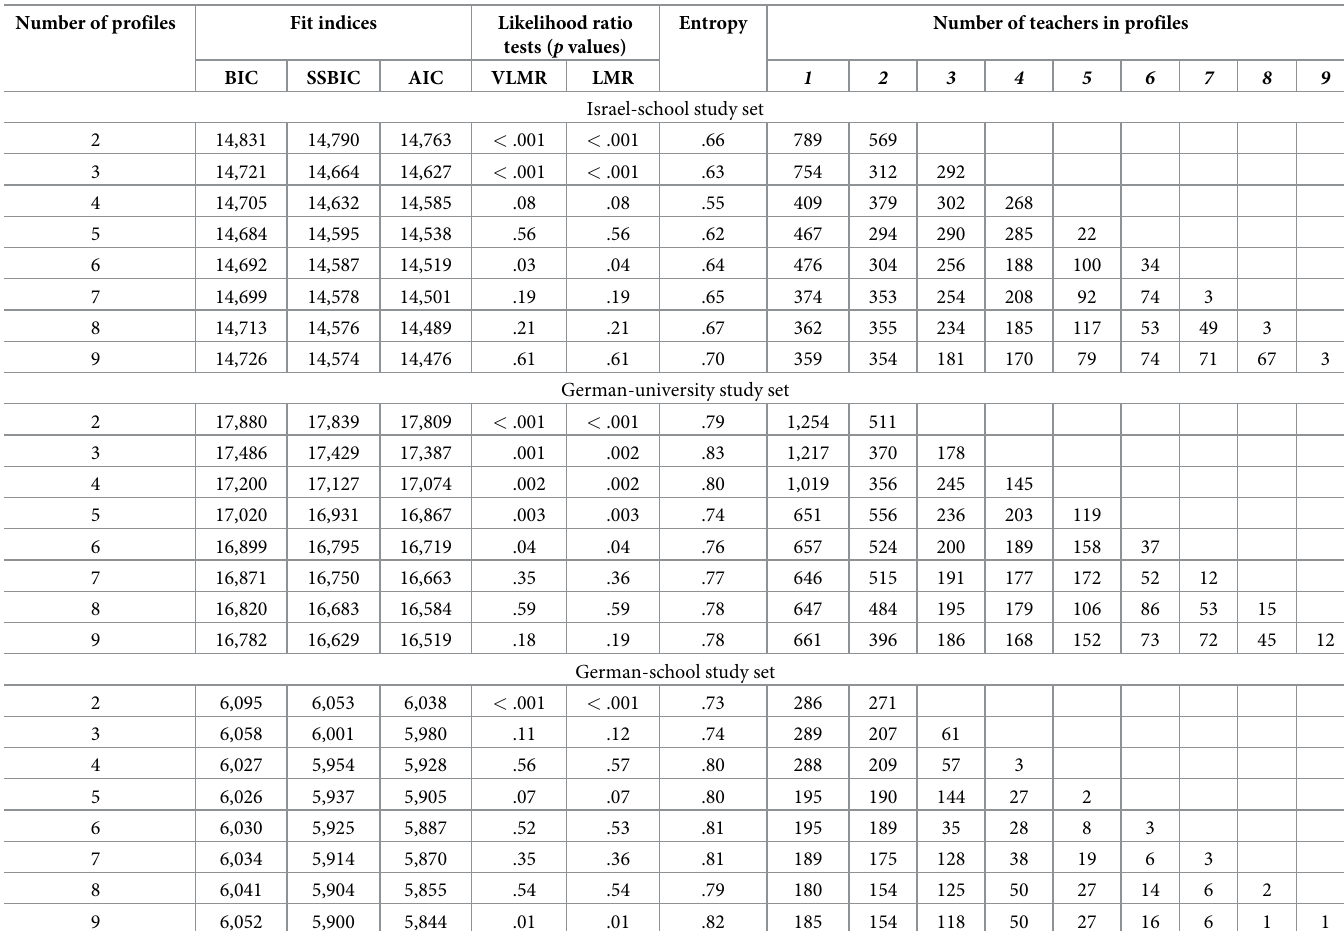
Table 3. Overview of LPA profile